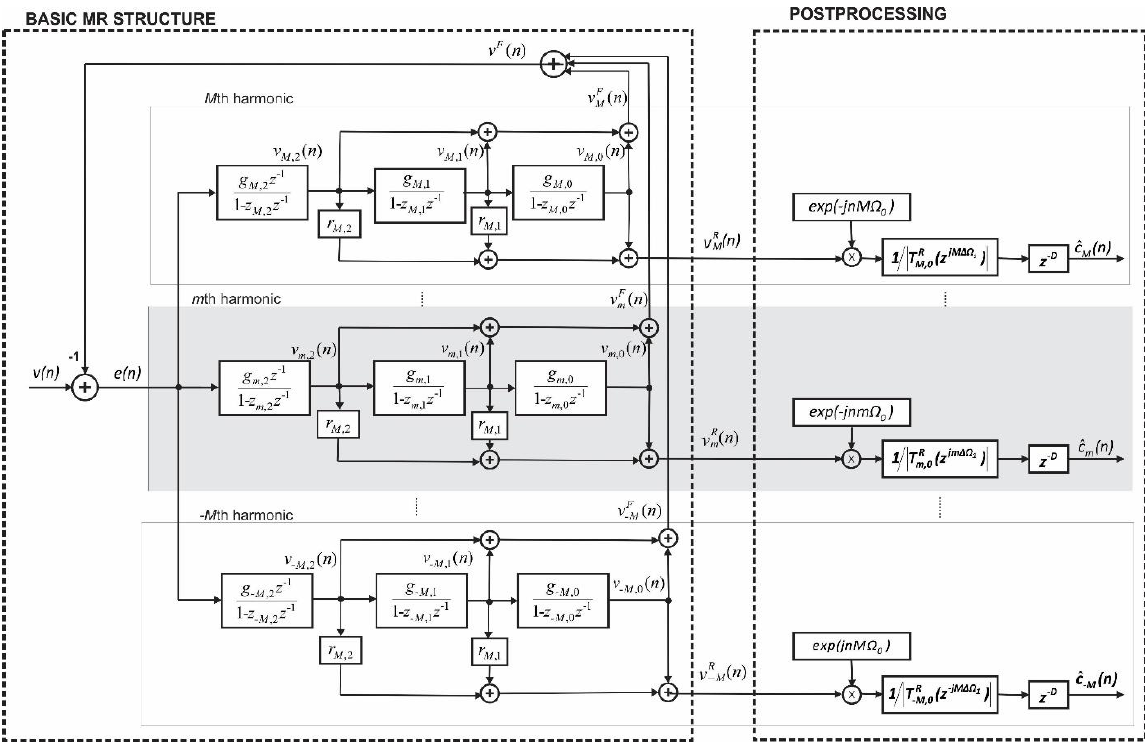
Figure 2. Structure of the third-order ( 𝐾 = 2 ) estimator.